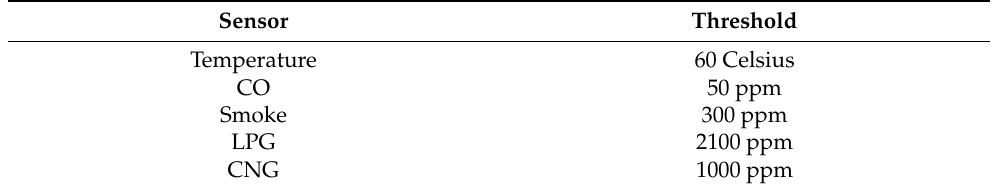
Table 1. Adopted thresholds for fire and gas leak detection selected from [9,10,12,13].